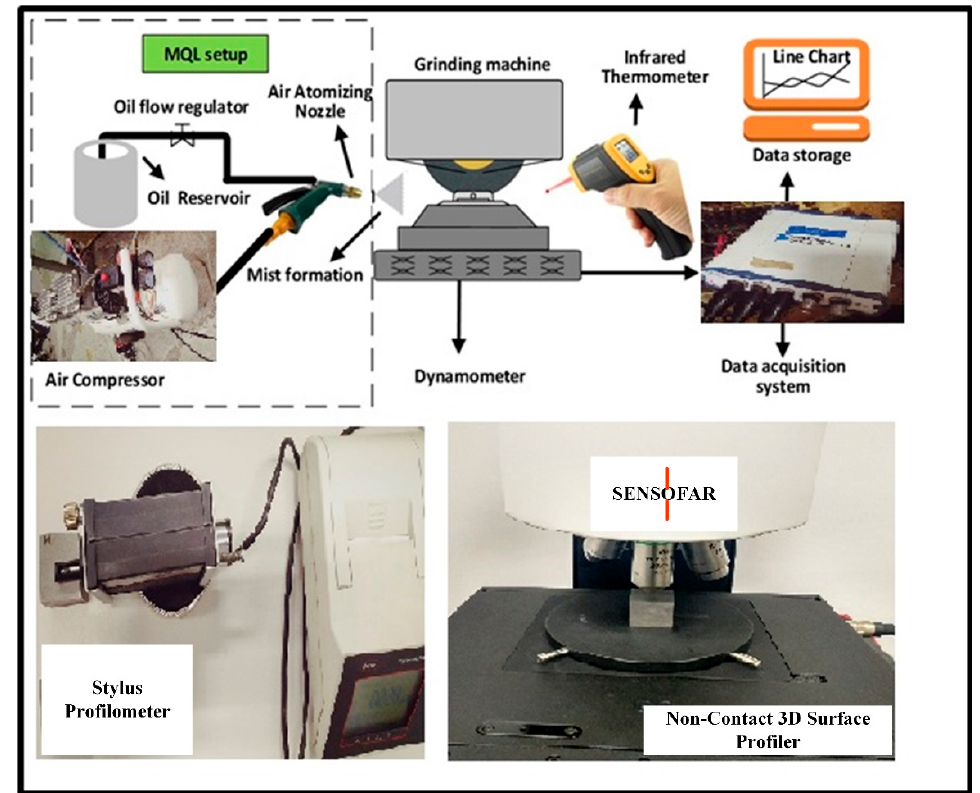
Figure 2. Schematic diagram showing minimum quality lubrication (MQL) working principle and response measurements.